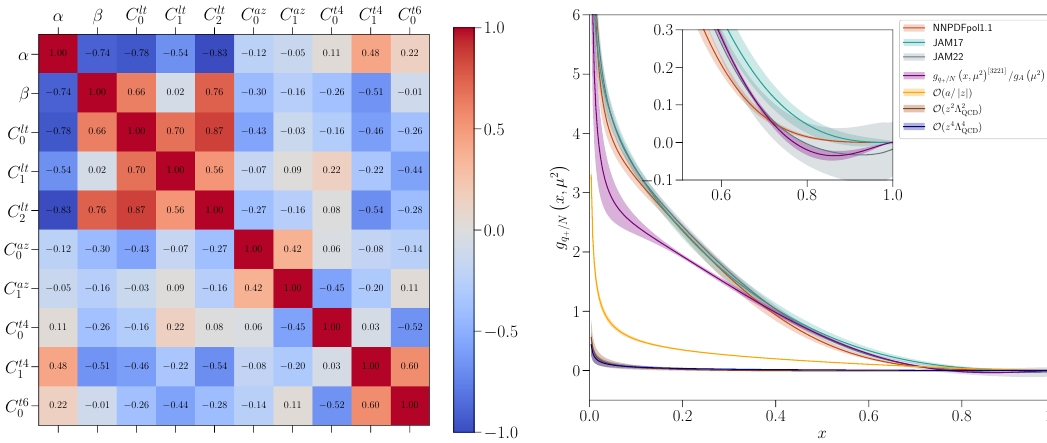
Figure 9 . (Left) Parameter correlations obtained from Cov ij / p Cov ii Cov jj of the fit presented in figure 8. (Right) Derived leading-twist CP -odd helicity quark PDF (purple) and x -space